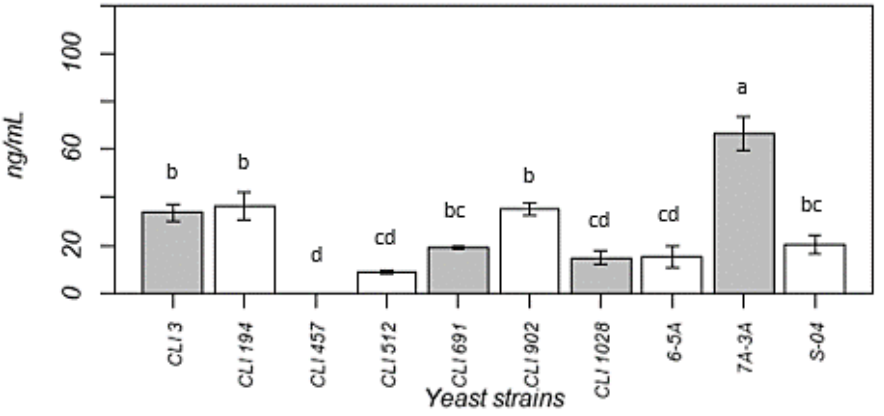
Figure 3. Melatonin production in beers fermented sequentially and in S-04 control strain, expressed in ng mL − 1 . The data shown are the average of three independent samples. Different letters next to the bars indicate a significant difference (Tukey tests: p < 0.05).